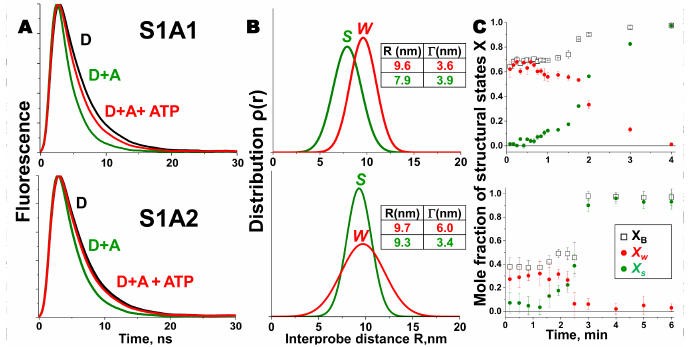
Figure 2. Structural states of the skeletal muscle actin-myosin complex detected by TR-FRET. ( A ) Fluorescence decay of 1 µ M AF568 actin (D, black) with 5 µ M AF647 labeled S1A1 and 10 µ M S1A2 respectively, in the absence (D + A, green) and presence of saturating ATP (D + A + ATP, red), acquired during the steady state. Faster decay in the presence of acceptor indicates FRET. ( B ) Interprobe distance distribution (best fit to a Gaussian function) corresponding to the bound acto-S1 complex, determined from data in ( A ) for S (green) and W (red) complexes. ( C ) Time dependence of FRET-detected mole fractions of the structural states in B, after addition of ATP (at time 0) to a mixture of donor-labeled actin and acceptor-labeled myosin S1. X B ( (cid:3) , black) is the fraction of donor that has bound acceptor. X B = X W + X S , where X W (red) and X s (green) are the mole fractions of W and S complexes. Adapted from Guhathakurta, P.; Prochniewicz, E.; Thomas, D.D. Amplitude of the actomyosin power